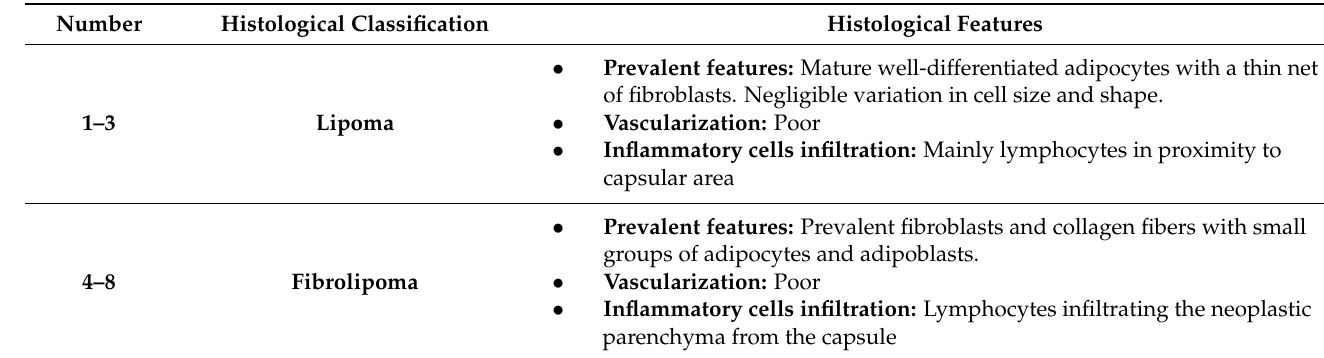
Table 1. Histological classification of the 16 neoplasms collected from striped sea bream and relative differential features. Number Histological